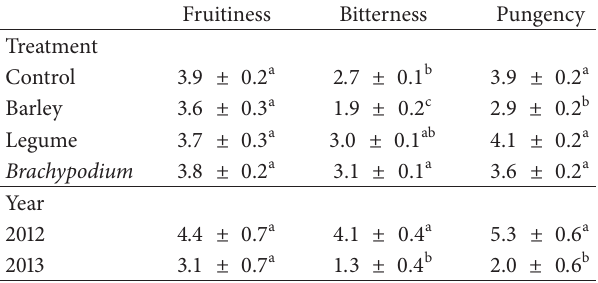
Table 6: VOO sensory characteristics LS means and standard deviation for treatments and years ( 𝑛 = 3 ). Covariates appearing in the model are evaluated at the following values: maturity index = 3.5.